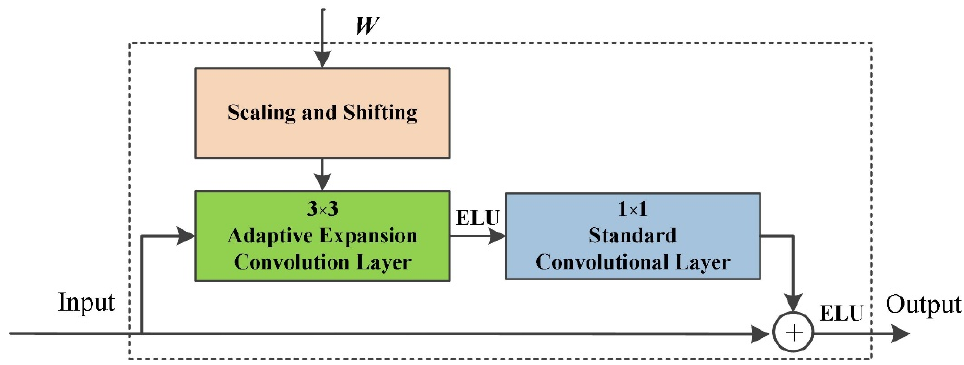
Figure 3. Architecture of Diet-PEPSI unit. Table 1. Detailed architecture of shared encoding network.